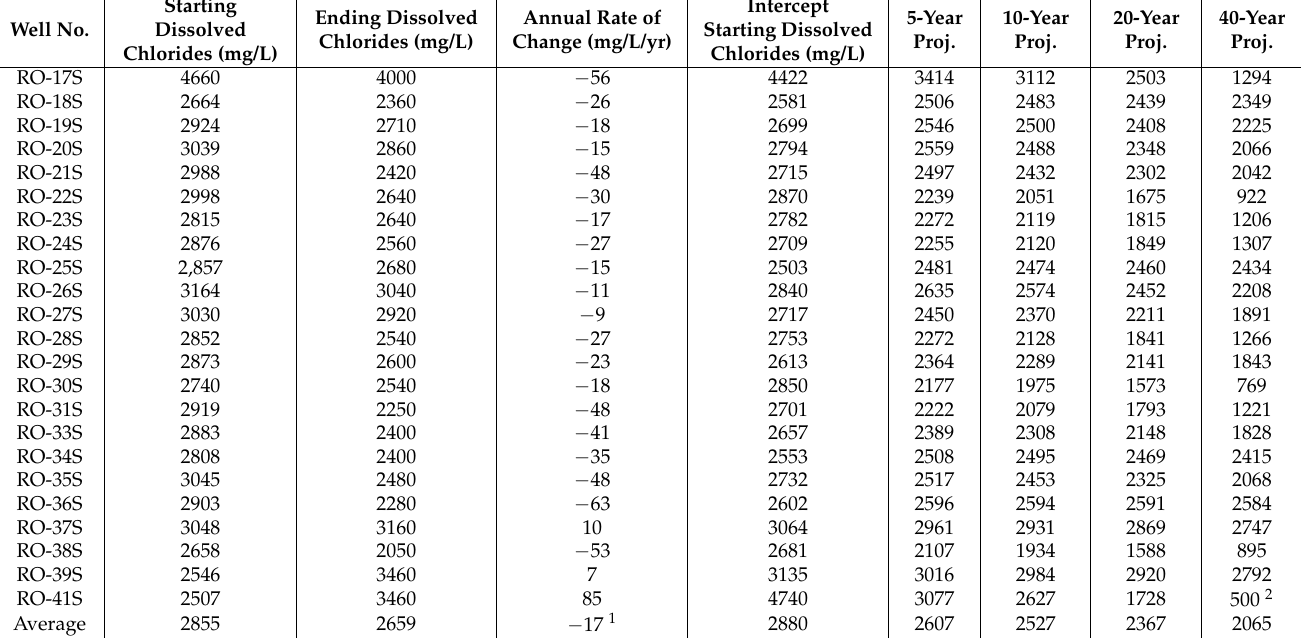
Table 4. Lower Hawthorn Aquifer period of record for starting and ending dissolved chloride concentration measurements. Well No. Months of Record RO-8S 162 July 2007 RO-9S 162 RO-10S